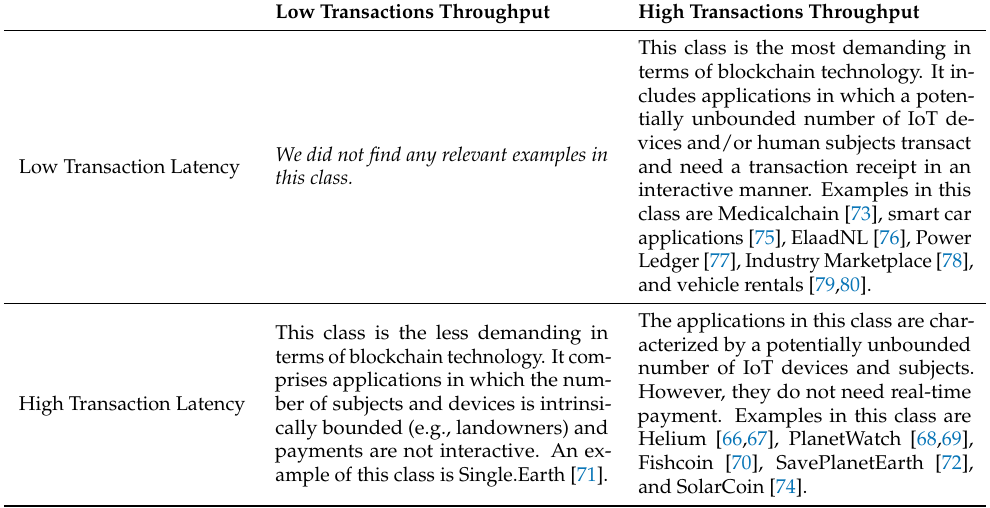
Table 6. Classification of the applications in shown Table